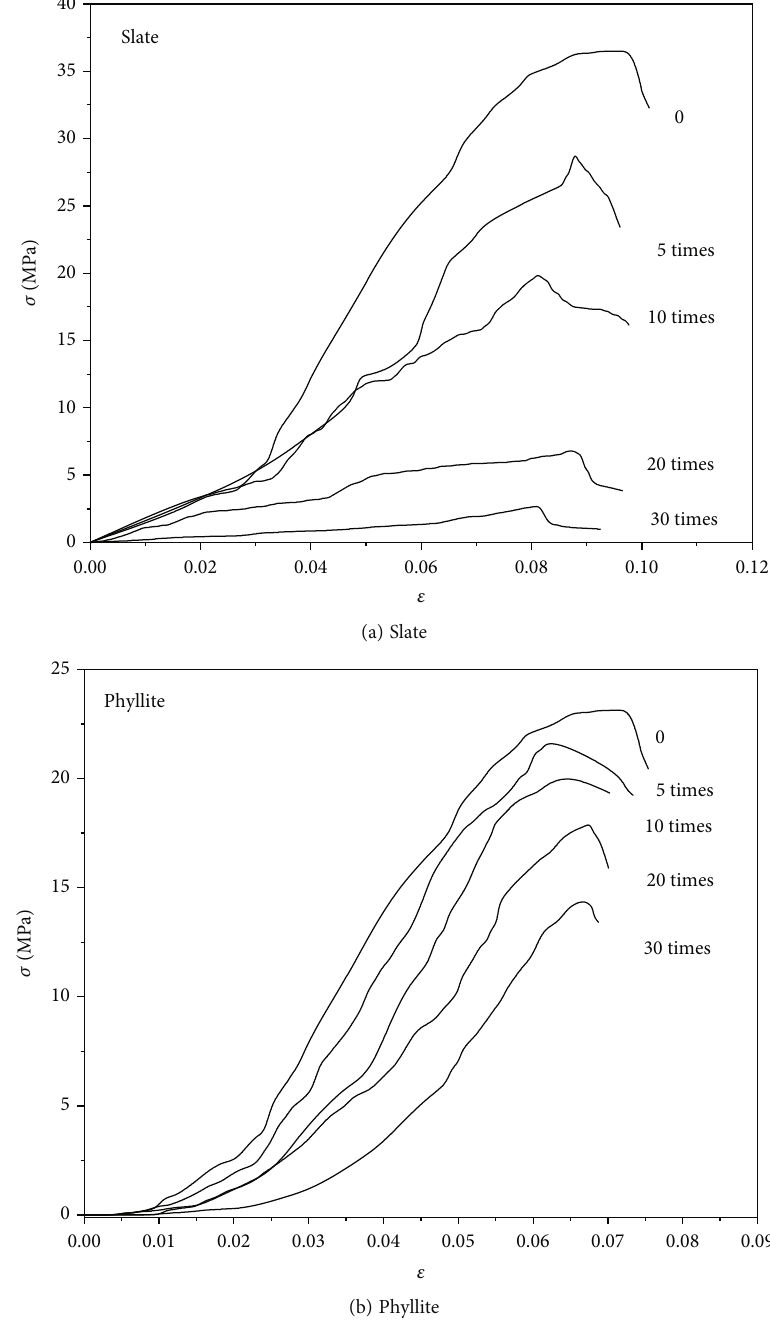
Figure 9: Stress-strain curves for slate and phyllite